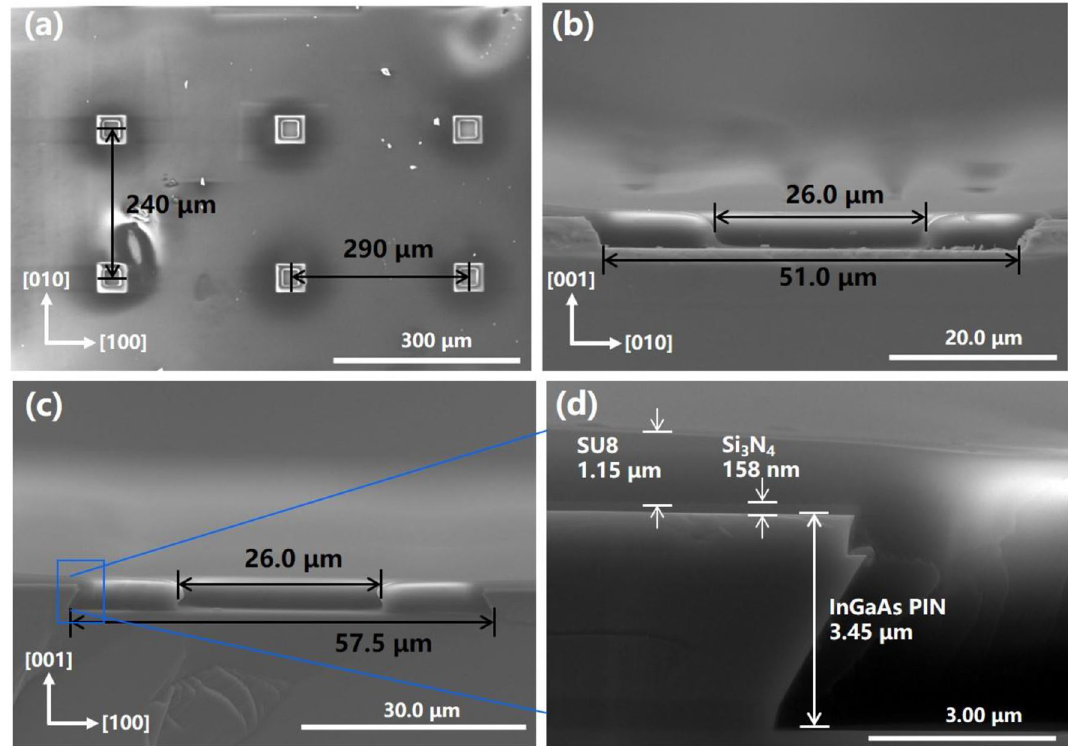
Figure 2. SEM image of etch holes in fabricated InGaAs PD based on the InP substrate: ( a ) The surface of the etch holes array. ( b , c ) The cross section of side wall covered with composite passivation layer in [100] and [010] direction. ( d ) A magnified view of a side wall of the outline area on the left shows side wall covered with Si 3 N 4 (158 nm) and SU-8 (1.15